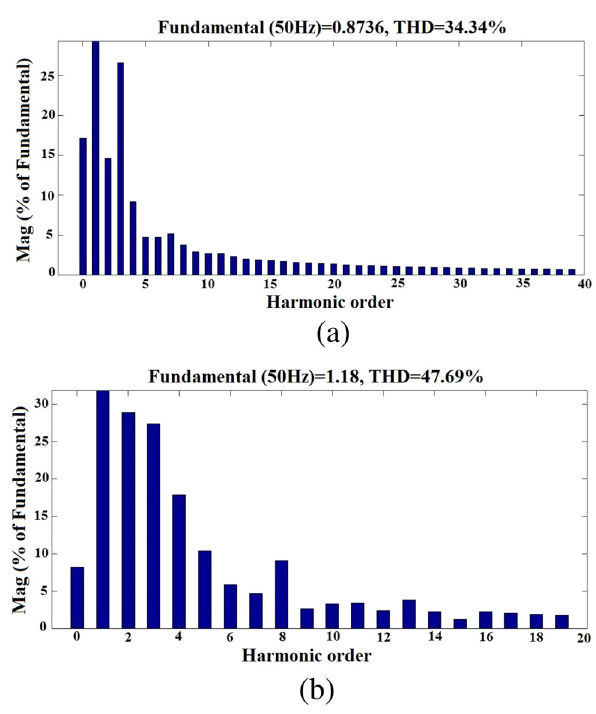
Figure 15: Harmonic spectrum: ( a ) FFN - SOSMC and ( b )